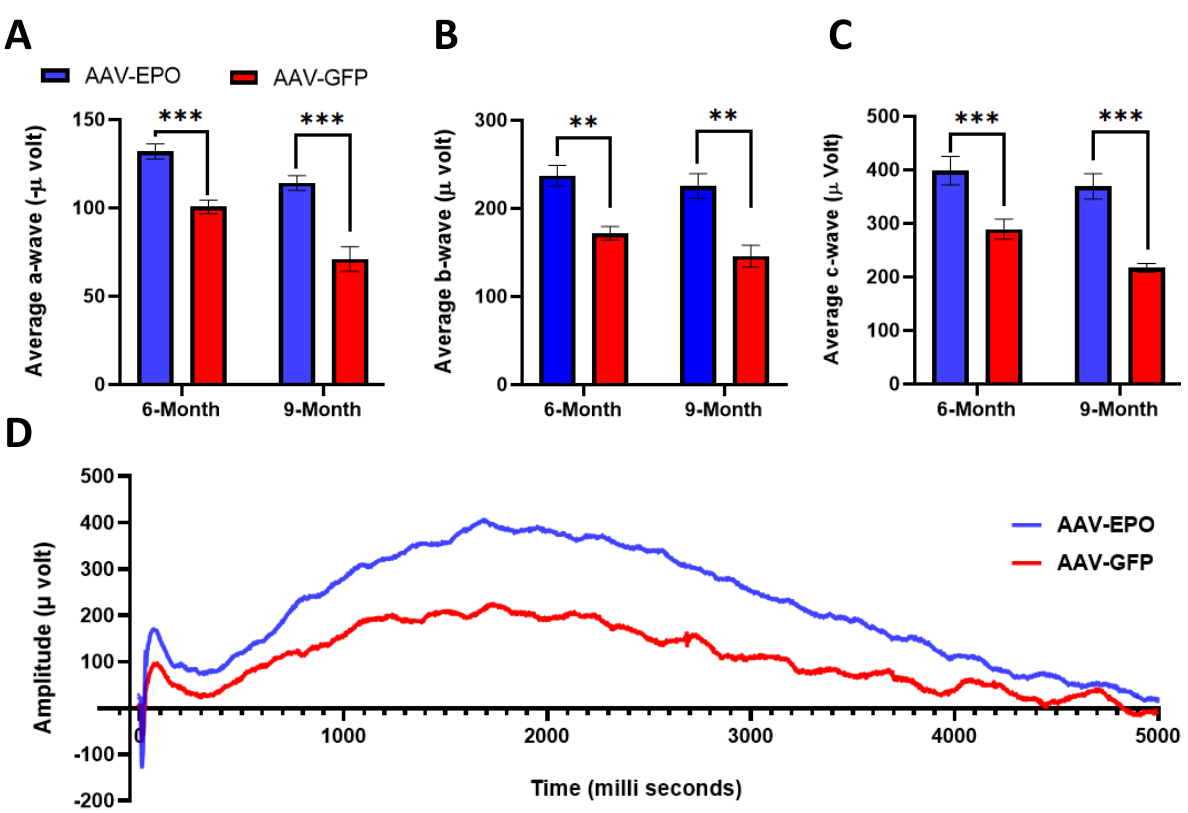
Figure 3. Improvement of Photoreceptor and RPE function. Dark-adapted full field electroretinogram (ERG) amplitudes measured at a light intensity of 20 cds/m 2 at 6 months (6mo) and 9 months (9mo) of age after subretinal delivery of EPO-R76E. In the EPO treated group, significant increases in ( A ) a-wave, ( B ) b-wave and ( C ) c-wave amplitudes were recorded both at 6 months ( n = 13) of age and 9 months of age ( n = 11) compared to untreated group injected with GFP vector. ( p < 0.01). Please refer to Supplementary Figure S1 for the ERG data shown as a box-and-whisker plot. ( D ) indicates the representative scotopic ERG waveforms at 9 months. ** p ≤ 0.01, *** p ≤ 0.001.